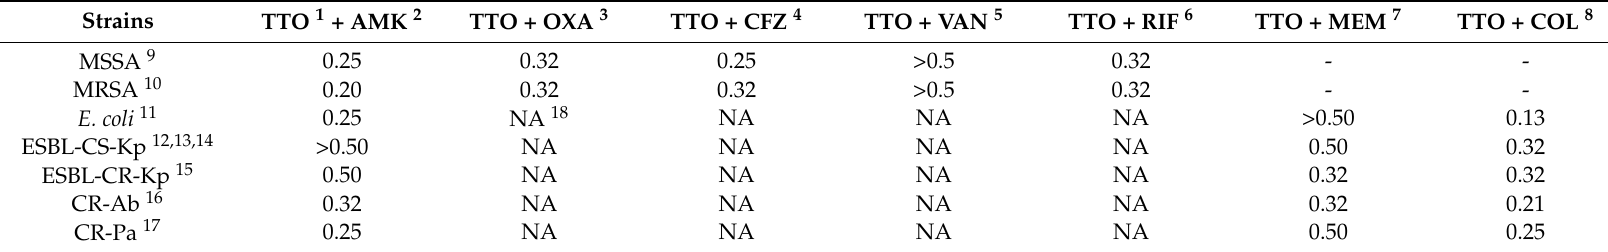
Table 3. Qualitative assessment of synergistic activity by FICI * values of TTO combined with different antimicrobials against MSSA, MRSA; Escherichia coli , ESBL-CS-Kp, ESBL-CR-Kp, CR-Ab, and CR-Pa.